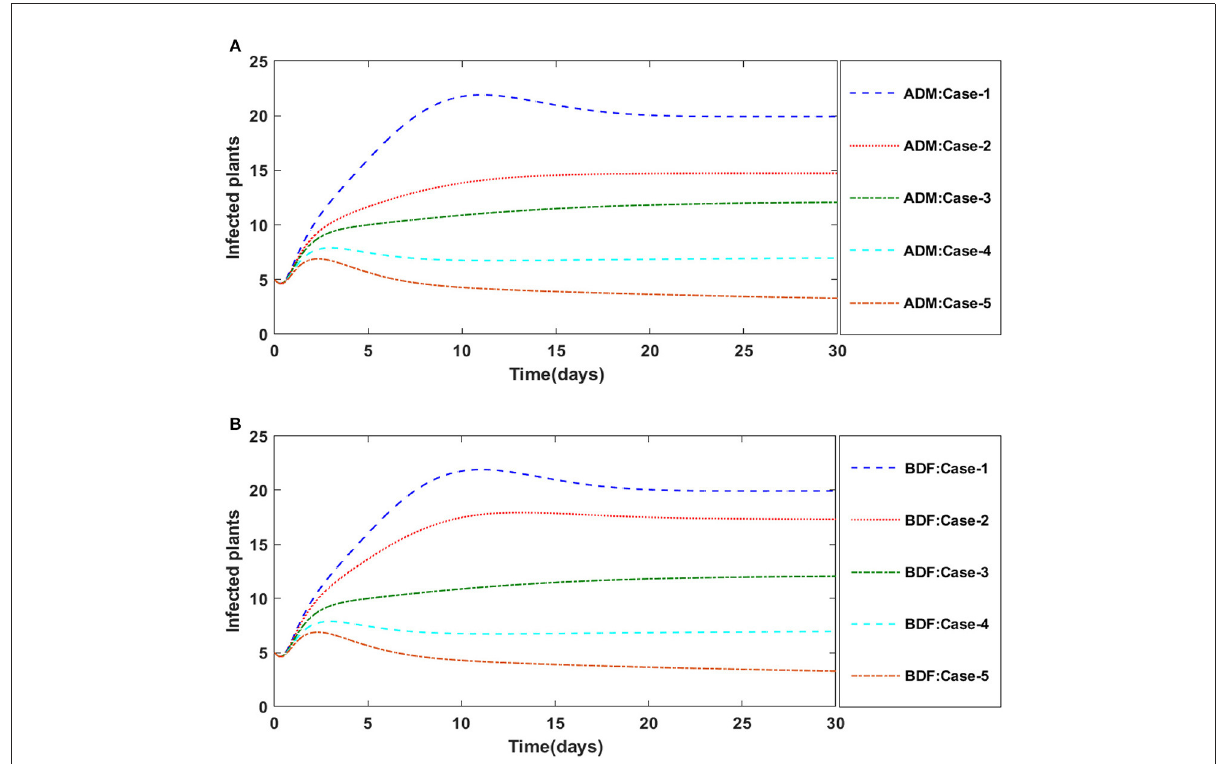
FIGURE23 (A) Dynamics of infected plants for the varition in r using ADM for model B2. (B) Dynamics of infected plants for the varition in r using BDF for model